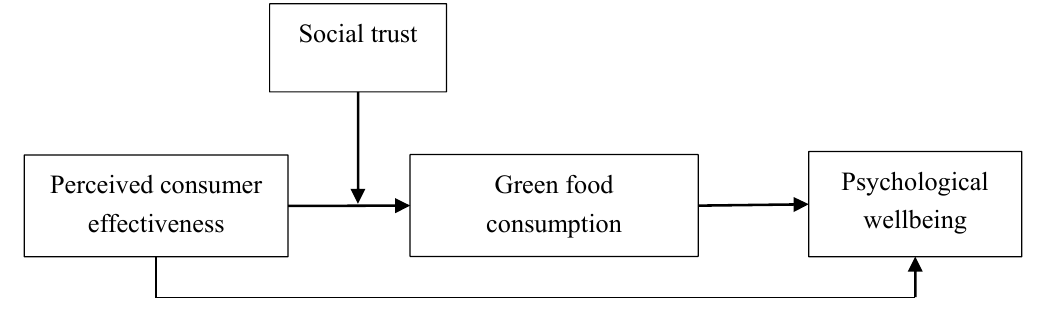
Figure 1. Conceptual framework of the study.